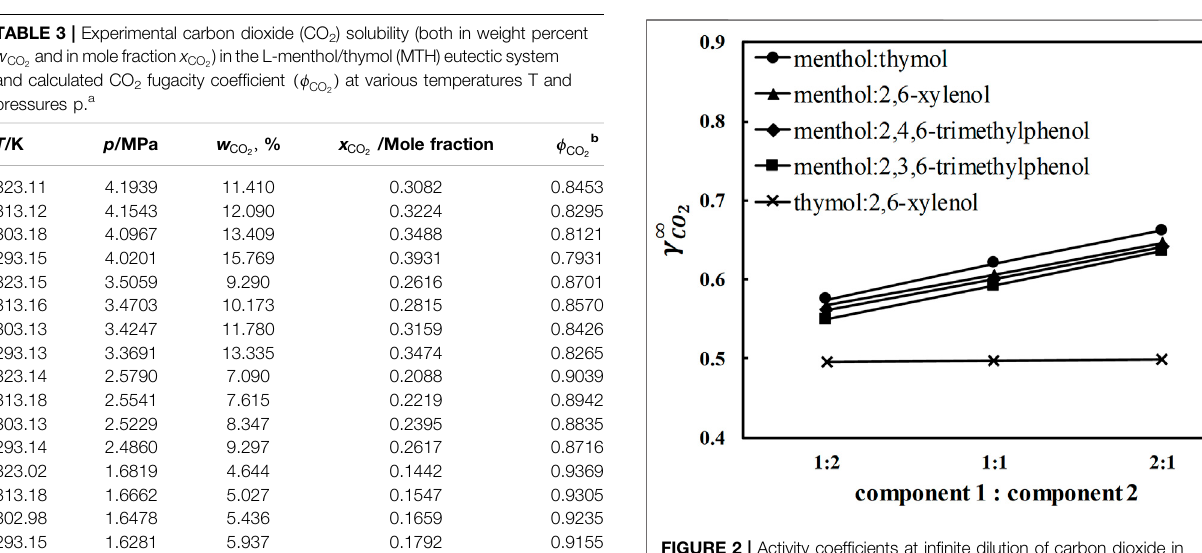
FIGURE 2 | Activity coef fi cients at in fi nite dilution of carbon dioxide in selected eutectic mixtures at 293.15 K calculated by COSMO-RS.